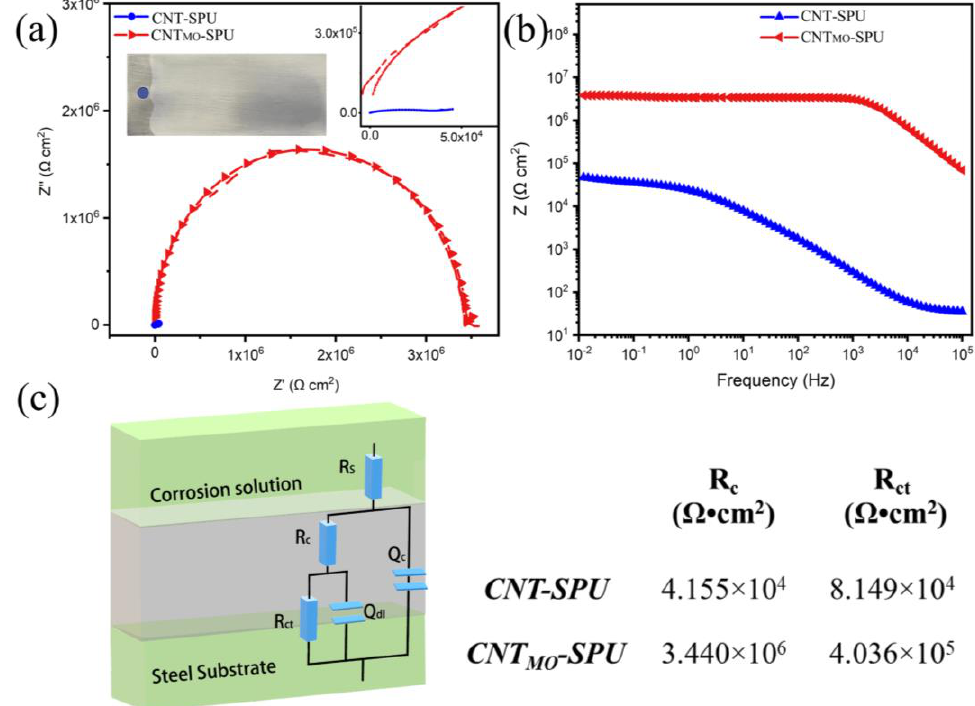
Figure 9. Nyquist ( a ) and Bode plots ( b ) of the synthesized CNT-SPU and CNT MO -SPU coatings after 48 h immersion in 3.5 wt% NaCl solution. The insert in ( a ) upper left corner is the photo of CNT MO -SPU coating. The equivalent circuit diagram model of coatings is shown in ( c ), and the main parameters of EIS fitting for CNT-SPU and CNT MO -SPU coatings are also listed in ( c ).